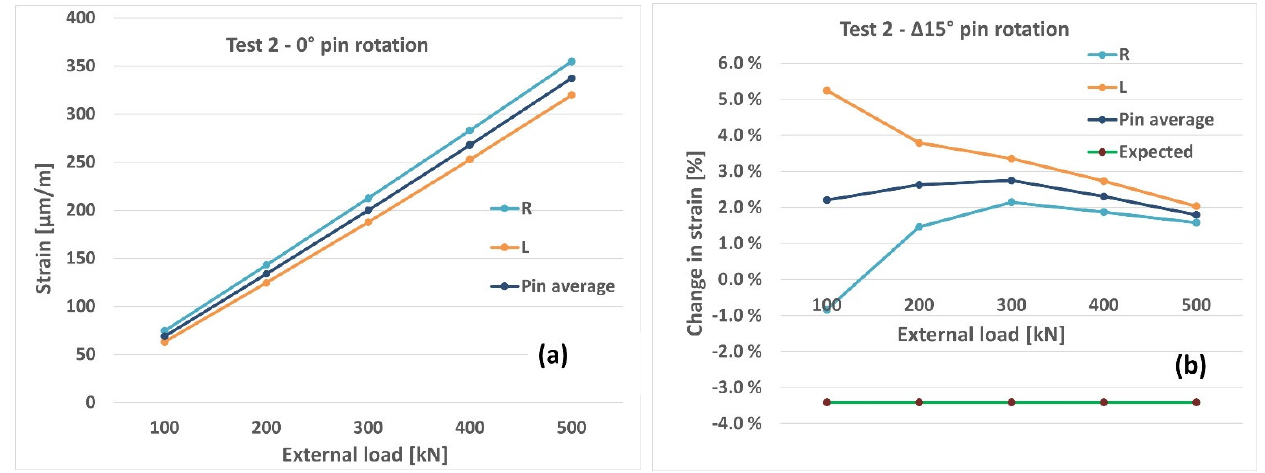
Figure 10. Test 2, ( a ) strains at 0° position, ( b ) percentage change of strains from 0° to 15° position.